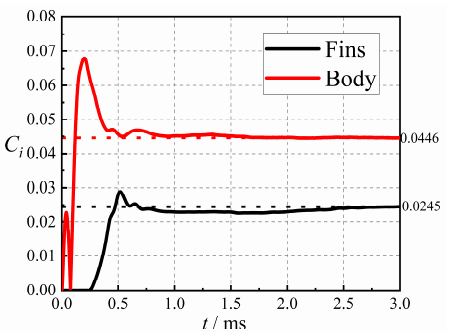
Figure 12. Variation of jet interference force coefficient of different aerodynamic components with time since lateral jet